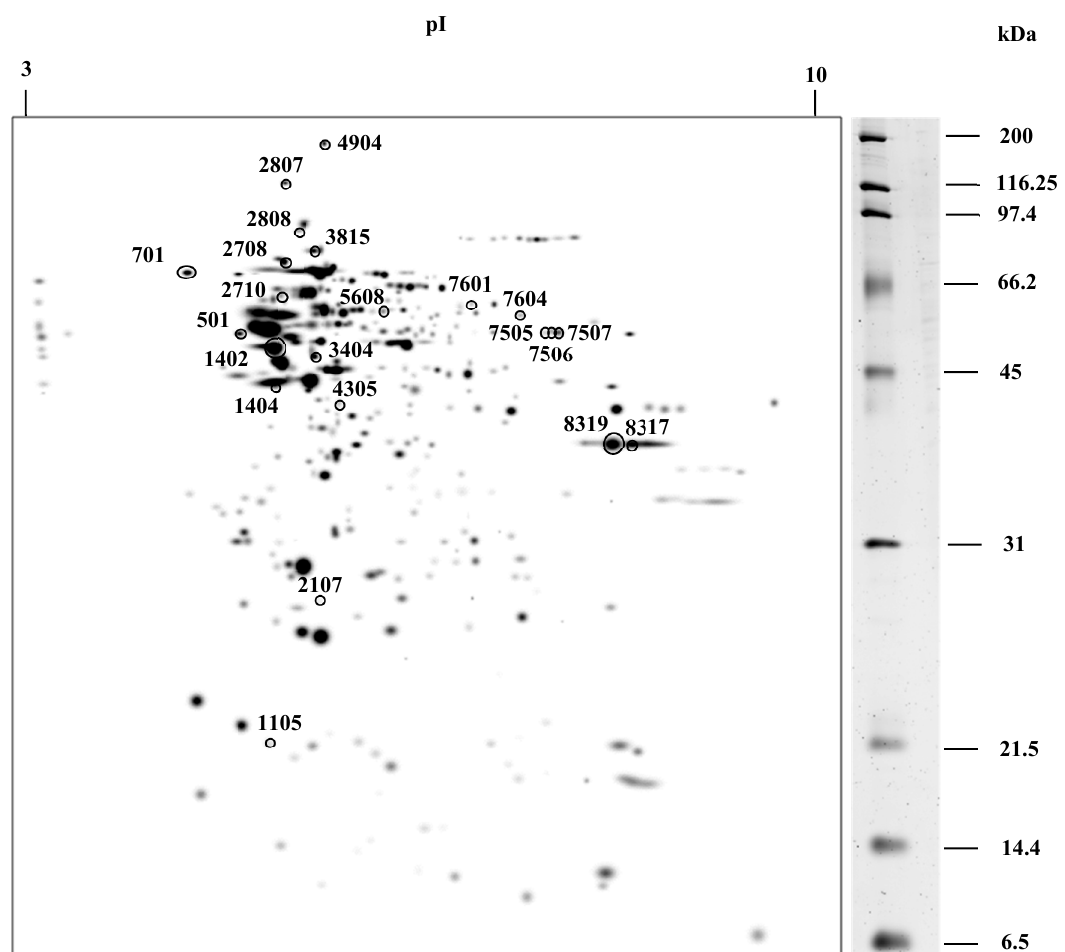
Figure 1. Master gel obtained from 2-D of the rat brain proteins under control and starvation conditions. The 22 spots that show a differential expression are circled. These were excised and digested with trypsin. The peptides obtained were analyzed by a matrix-assisted laser desorption-ionization-time of flight mass spectrometer MALDI-TOF/TOF.